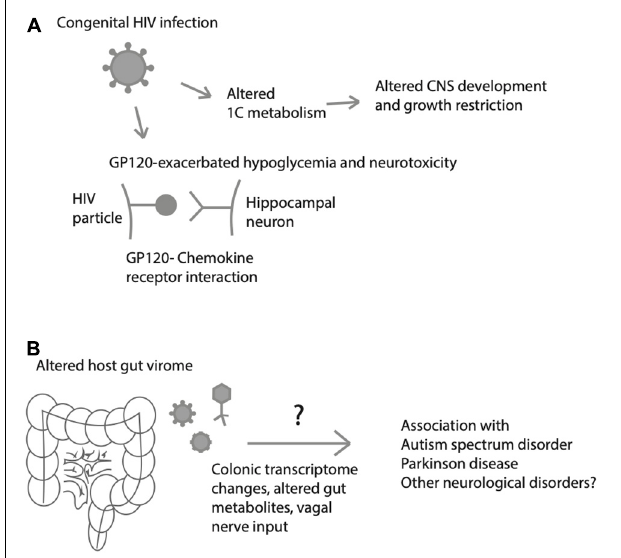
FIGURE 3 | Effects of viruses on fetal/neonatal metabolism and neurological disease or injury. (A) Metabolic effects of HIV that may lead to altered fetal growth, central nervous system (CNS) development), glucose processing and excitotoxic brain injury. (B) Neonatal gut virome influences colonic transcriptome and gut metabolites, which may predispose to a variety of neurological disorders later in